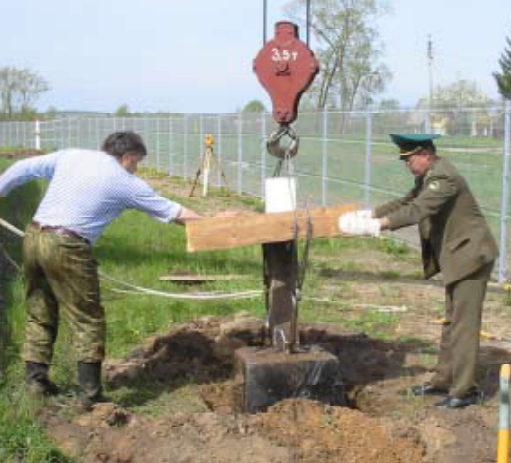
Fig. 1. State boundary crossing signs